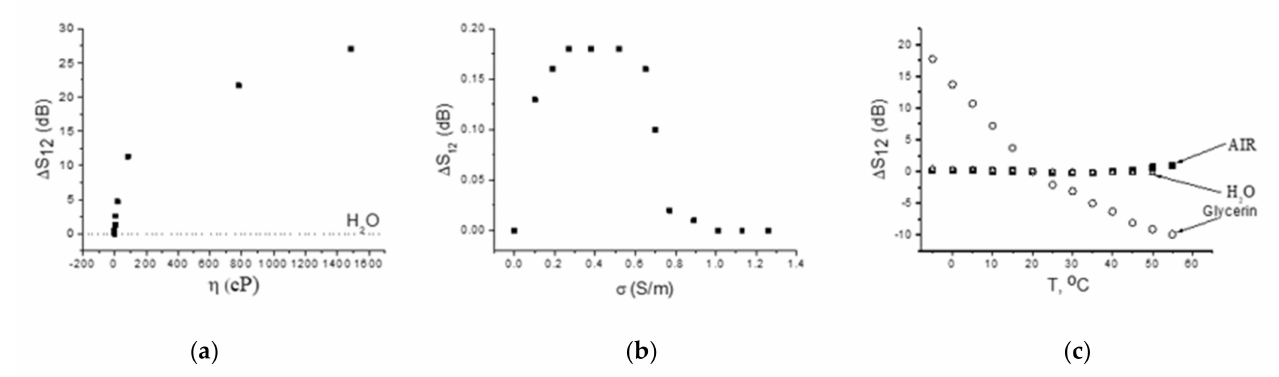
Figure 6. Calibration curves of the sensor prototype for viscosity ( a ), electric conductivity ( b ), and temperature ( c ) for ST,X-quartz plate, h/ λ = 1.0, mode frequency 49.74 MHz. Liquids are over the propagation path L = 22 mm on the bottom of the plate.